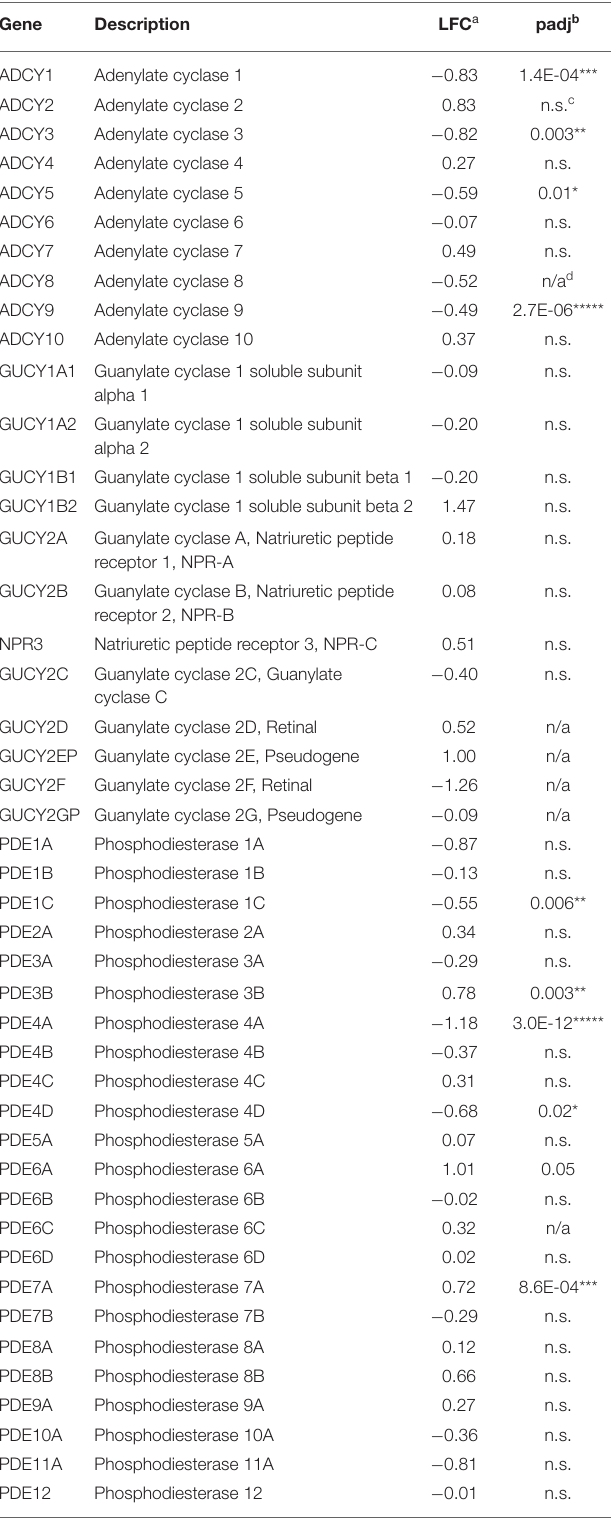
TABLE 3 | Differential gene expression in cAMP/cGMP synthesis and